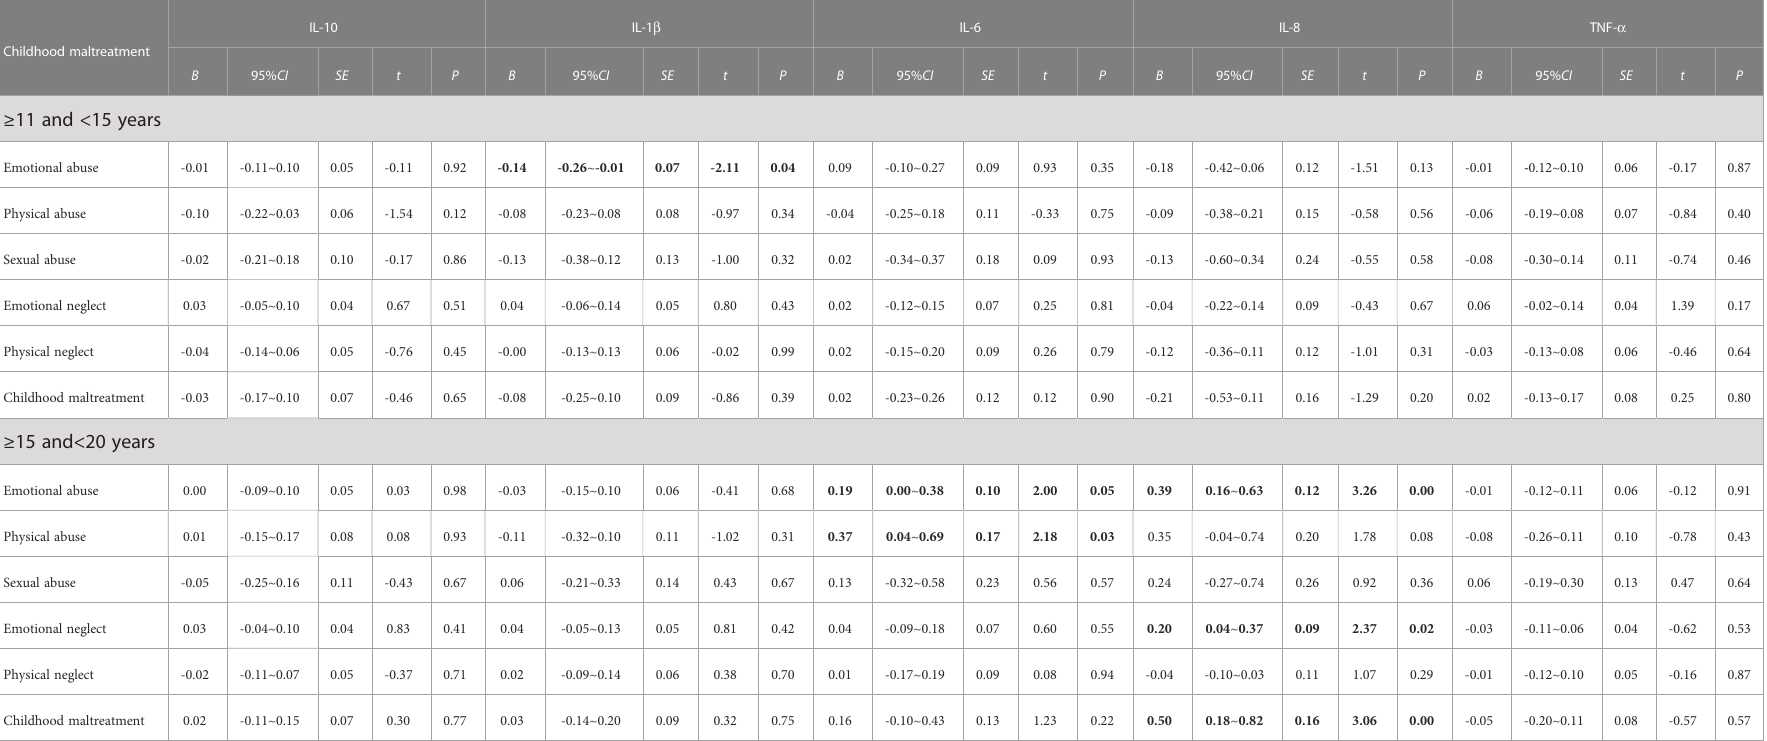
TABLE 5 Age-speci fi c associations of childhood maltreatment with the levels of peripheral serum in fl ammatory cytokines.